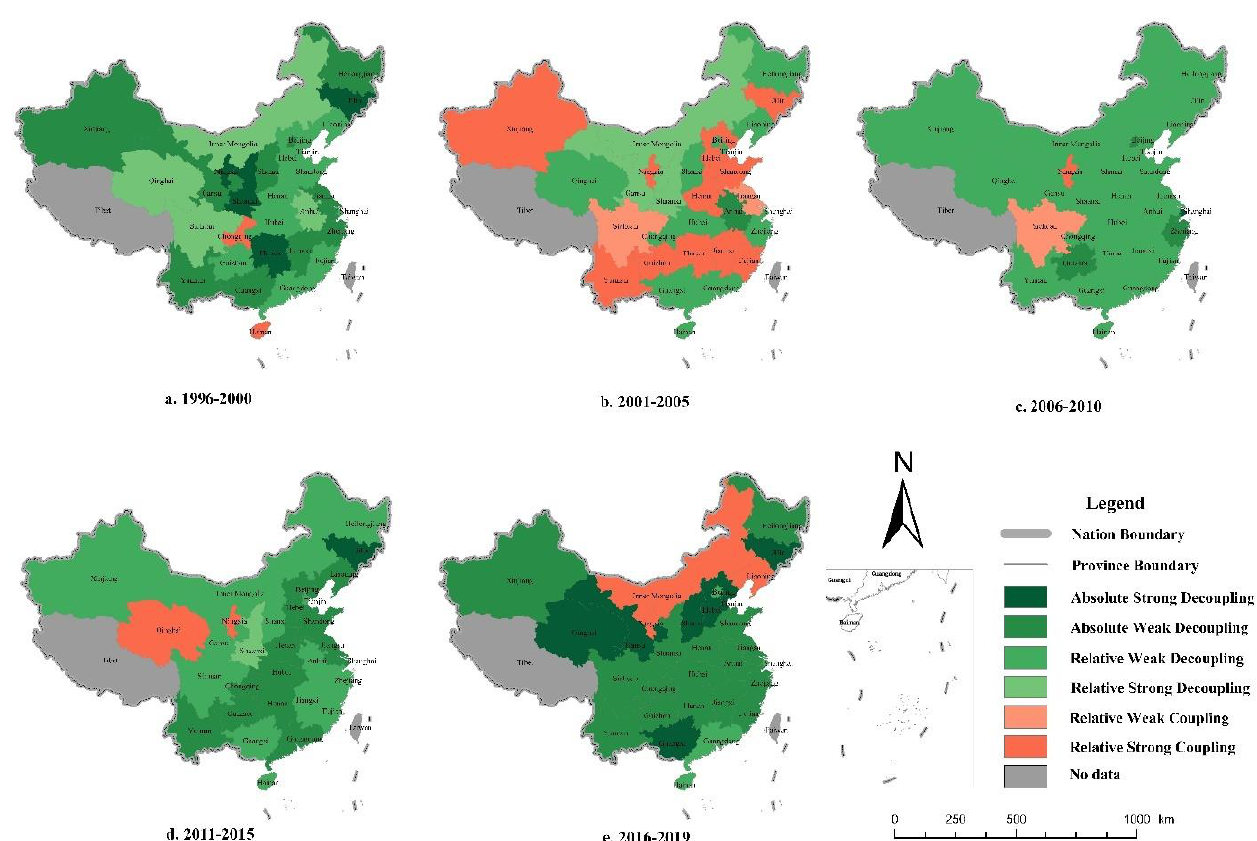
Figure 7. Decoupling status of industrial CO 2 emissions from economic growth.